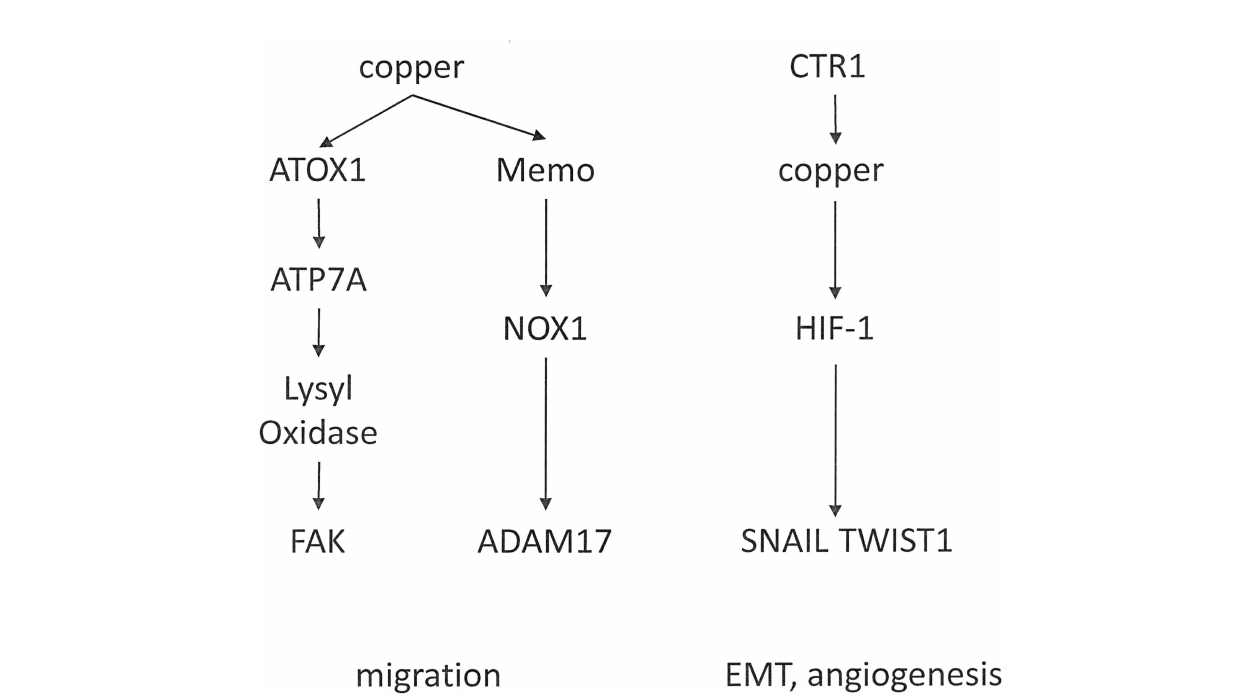
FIGURE 5 | Distinct functions of copper in cancer progression. Copper mediates cell migration. Through a different mechanism, it can effectuate epithelial- mesenchymal transition and